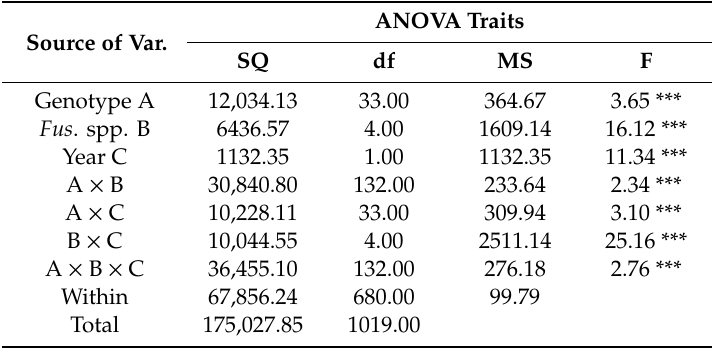
Table 11. Toxin contamination in KR, ANOVA of the toxin results from Table 9, 2010–2012, n = 34. ANOVA Traits Source of Var. SQ df MS